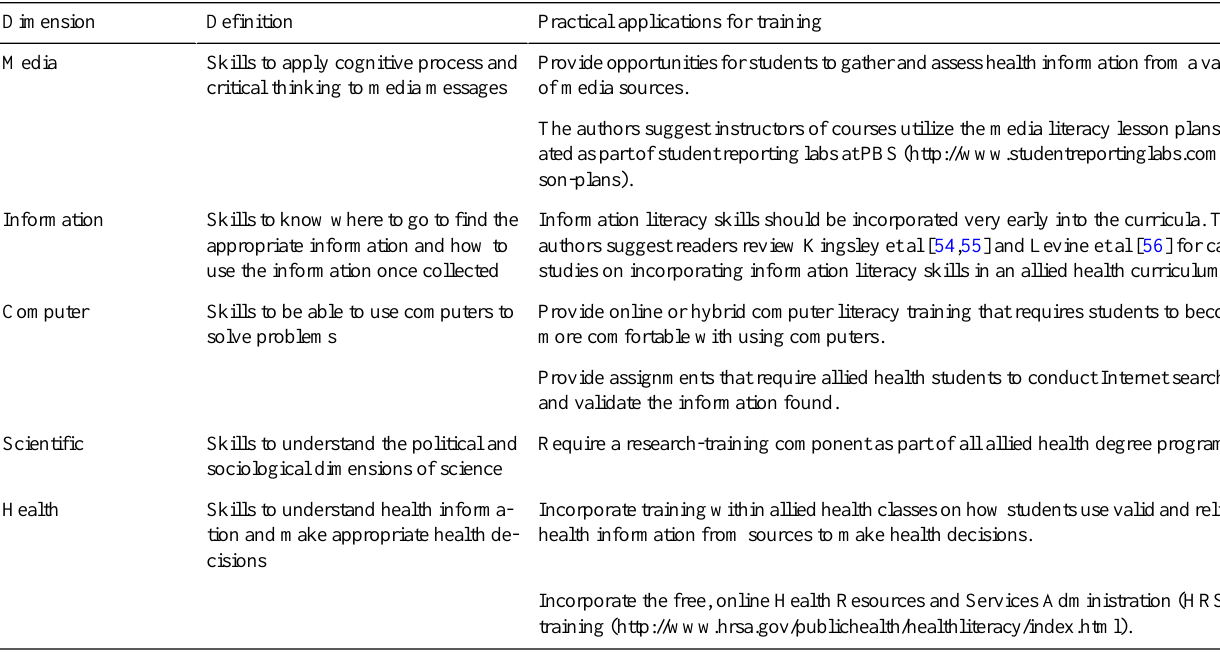
Table 5. Practical applications for training allied health students using the dimensions of eHealth literacy. Practical applications for